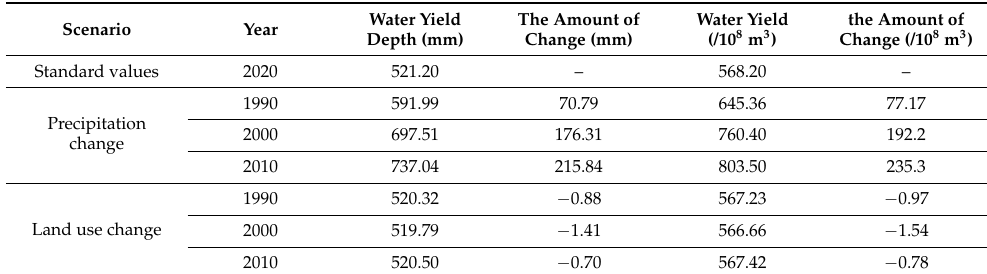
Table 3. Simulation of water yield in water source region under different scenarios of constant land use and constant